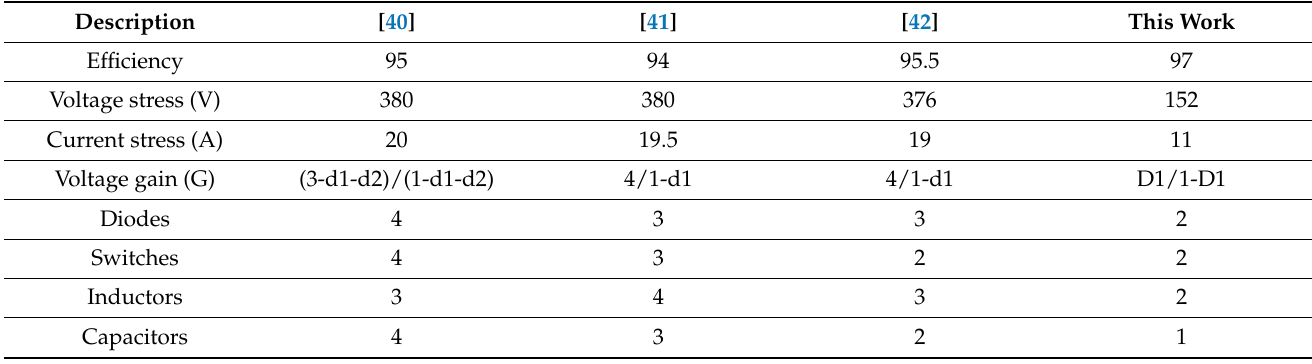
Table 3. Comparison of the proposed model with current approaches.